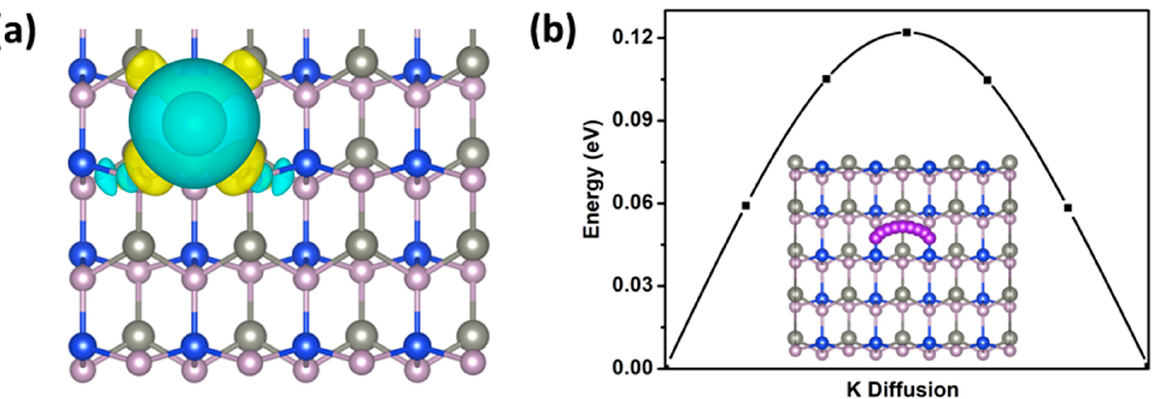
Figure 6. ( a )The charge density difference with the adsorption of K atom with the isosurface level of 0.01 e/Å 3 . ( b ) Energy profile for the diffusion of K on the surface of ZnSiP 2 monolayer along the path of the inset. The purple ball represents the K atom.